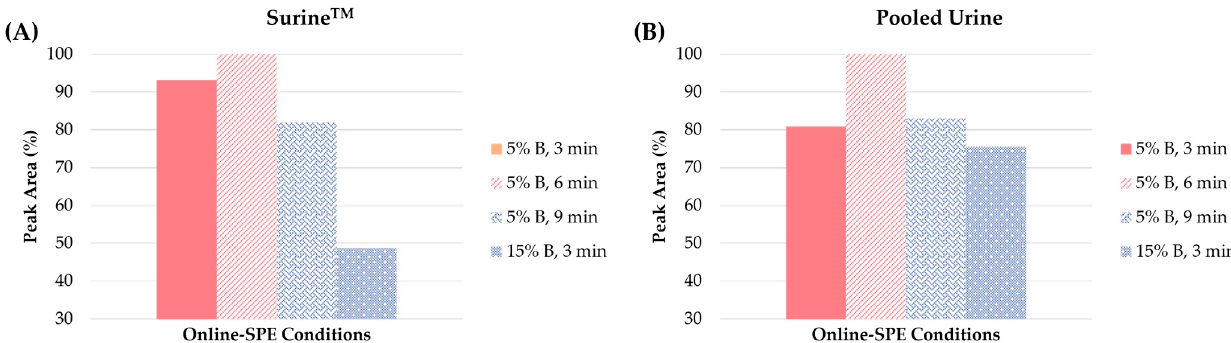
Figure 5. Influence of the different concentrations of solvent B (methanol) in the loading solution (5% or 15%) and the time of the loading and washing step (3, 6 or 9 min) on the peak area of clenbuterol in ( A ) Surine TM and ( B ) pooled urine.